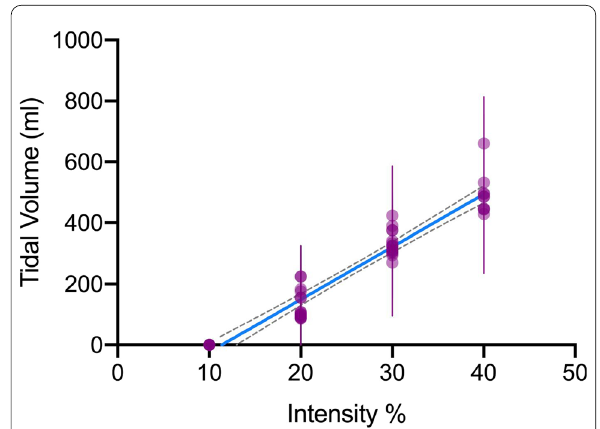
Figure 1—Tidal volume generated by bilateral non-invasive electro- magnetic phrenic nerve stimulation in ml per ideal body weight with different intensities (10%, 20%, 30%, 40%) of the magnetic stimulator. Linear correlation with 95% CI (p < 0.001; r2 0,63). Conclusion: Non-invasive bilateral phrenic nerve stimulation with an stimulation intensity of 20–30% seems to be able to non-invasively generate a tidal volume of 3–6 ml/kg IBW in pulmonary healthy nor- mal-weighed anesthetized patients. Whether this non-invasive tech- nique can prevent or attenuate VIDD has to be assessed in critically ill